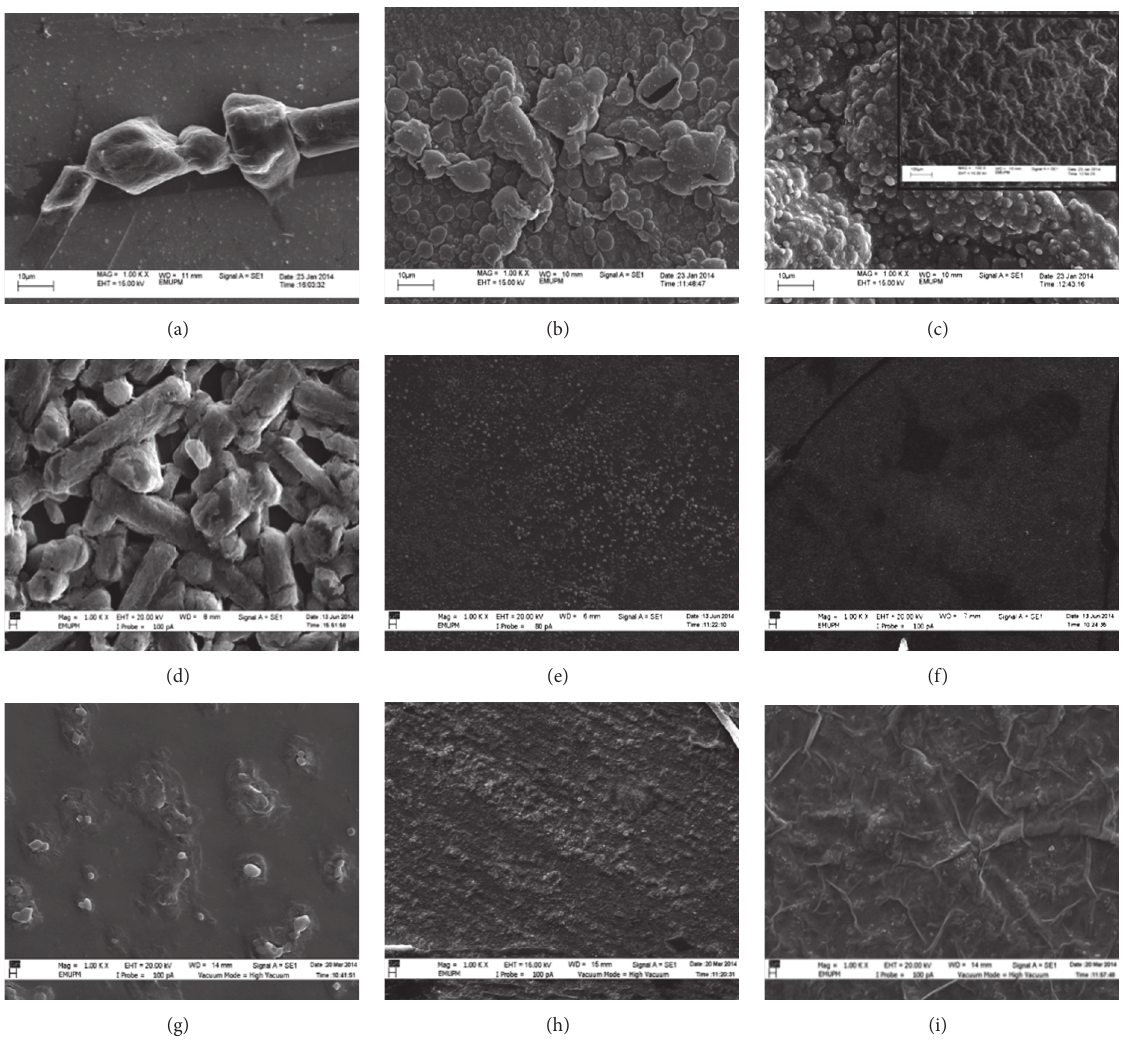
Figure 5: SEM micrographs of (a) 1 mM PEDOT, (b) 5mM PEDOT, (c) 10mM PEDOT, (d) 1mM PANI, (e) 5 mM PANI, (f) 10mM PANI, (g) 1mM PPy, (h) 5 mM PPy, and (i) 10mM